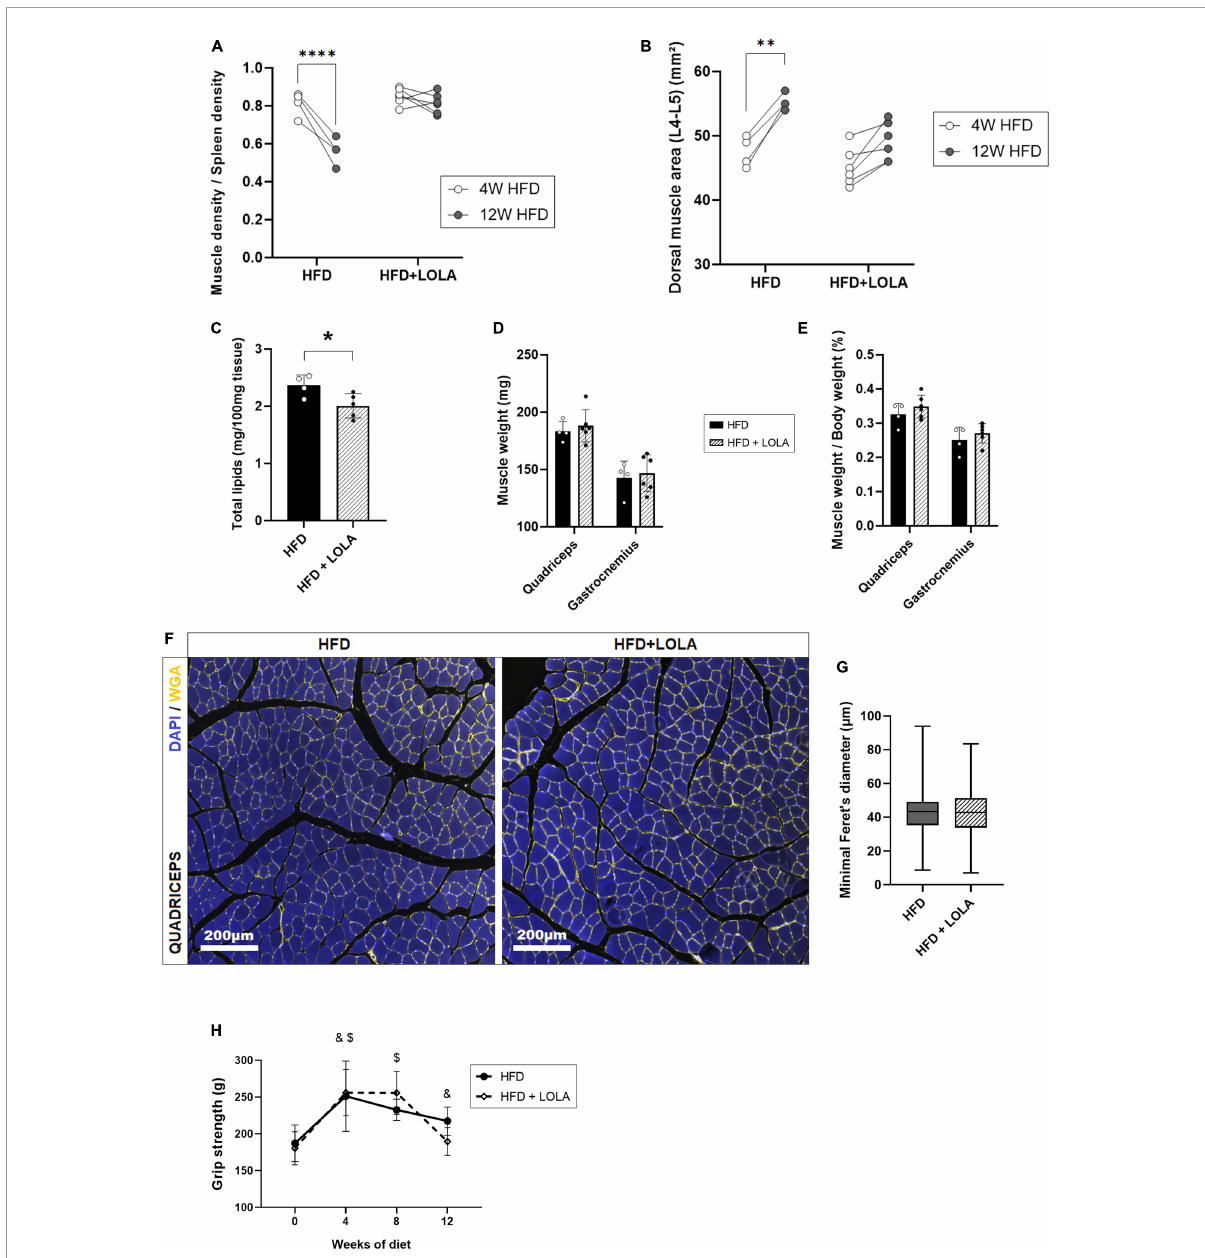
FIGURE4 L-Ornithine L-Aspartate (LOLA) prevents myosteatosis in NASH. (A) Dorsal muscle-to-spleen density measured in vivo by micro-CT in foz/foz mice (FOZ) fed a high-fat diet (HFD) and given LOLA or plain water ( n = 4–6); (B) Dorsal muscle area (L4–L5 averaged) measured in vivo by micro-CT in HFD and HFD + LOLA ( n = 4–6); (C) Total lipids content measured in gastrocnemius from HFD and HFD + LOLA ( n = 4–6); (D) Muscle weight and (E) muscle/body weight measured for quadriceps and gastrocnemius from HFD and HFD + LOLA ( n = 4–6); (F) Wheat-germ agglutinin (WGA) staining of myofibers performed on paraffin-embedded quadriceps sections; (G) Quantification of myofibers size performed on quadriceps WGA-stained sections ( n = 4–6); (H) 4-limb grip strength measured in HFD and HFD + LOLA ( n = 4–6, repeated measures two-way ANOVA, with & HFD significantly different from T0, and $ HFD + LOLA significantly different from T0). All data are represented as mean ± SD, ∗ p < 0.05, ∗∗ p < 0.01, ∗∗∗∗ p < 0.0001. Statistical tests used: (C,D,E,G) Unpaired two-tailed t -test. (A,B,H) repeated-measures two-way ANOVA followed by post hoc Bonferroni